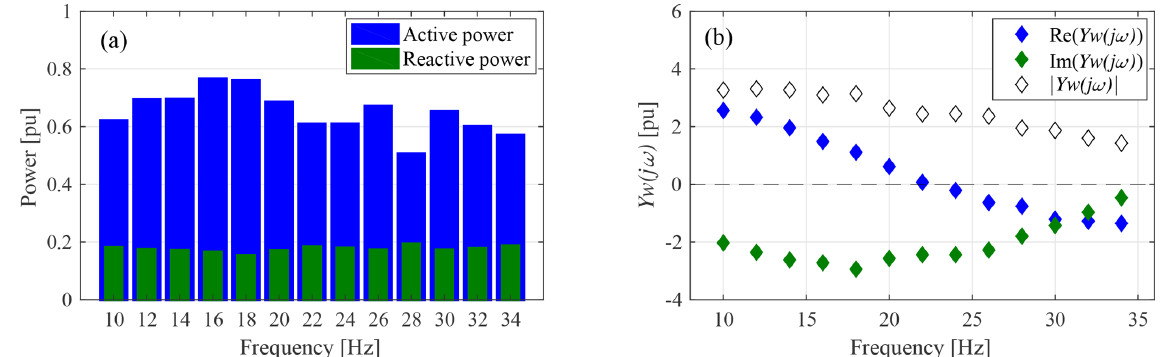
Figure 12. Results of frequency scan on the wind turbine operated at 65% of power production: operating points prior the scan and admit- tance components measured.